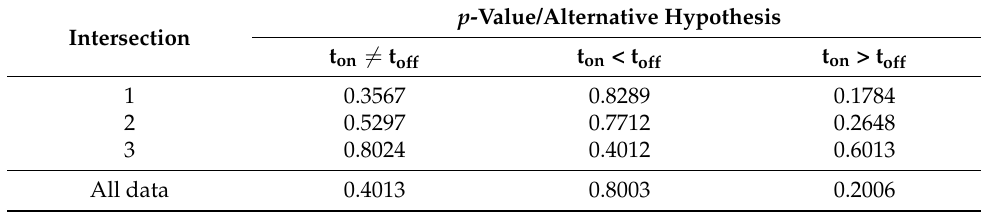
Table 4. Pearson test of compliance of the travel times after the green signal with the GSCT on (t on ) and off (t off